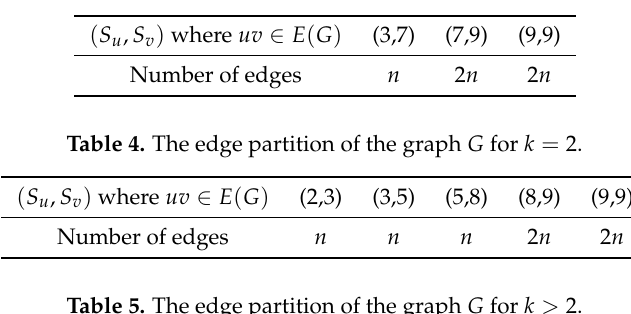
Table 3. The edge partition of the graph G for k = 1.